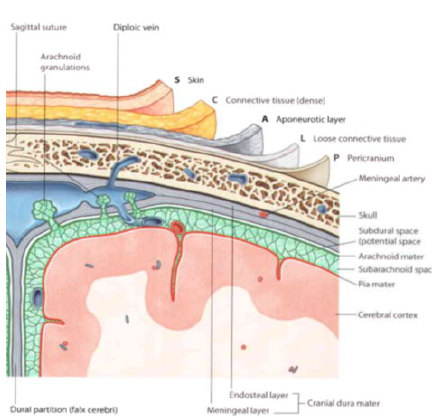
Fig. 1: Cross-section of meninges in brain